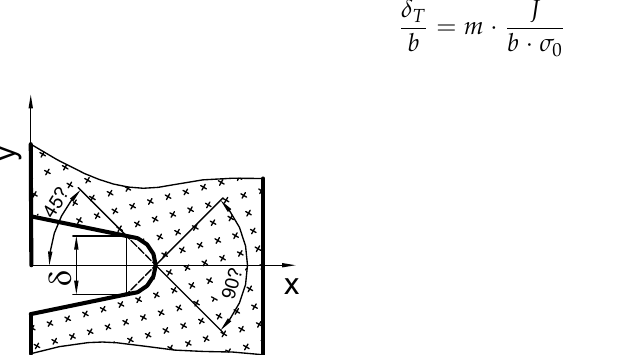
Figure 16. Shih’s concept [14] used to determine the crack tip opening displacement [18]. Denoted